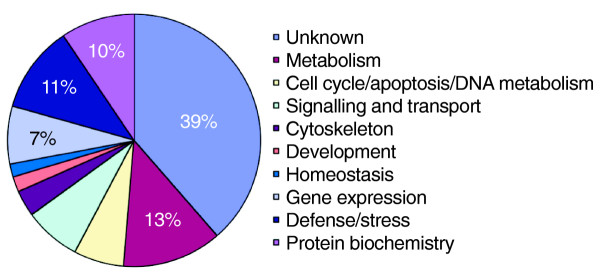
Gene ontology classification of the top 188 genes identified from the cDNA array. Percentage representations are given for the prominent categories.